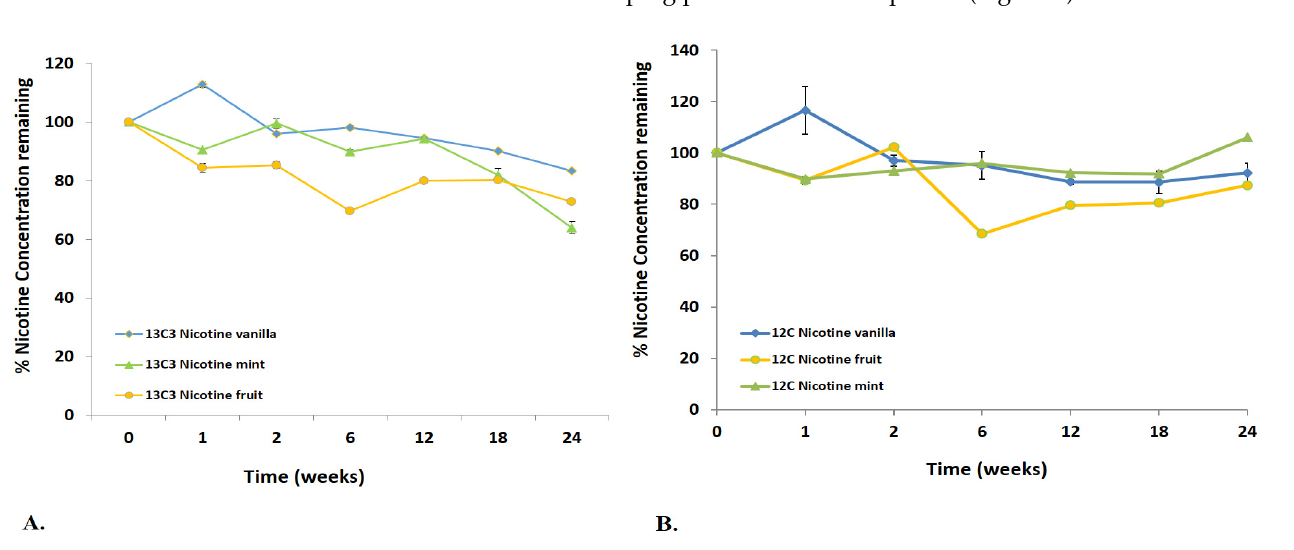
Figure 2. ( A ) . Stability of 13C 3 nicotine; ( B ). Stability of 12 C nicotine in three lots each: vanilla, mint and fruit vaping products.